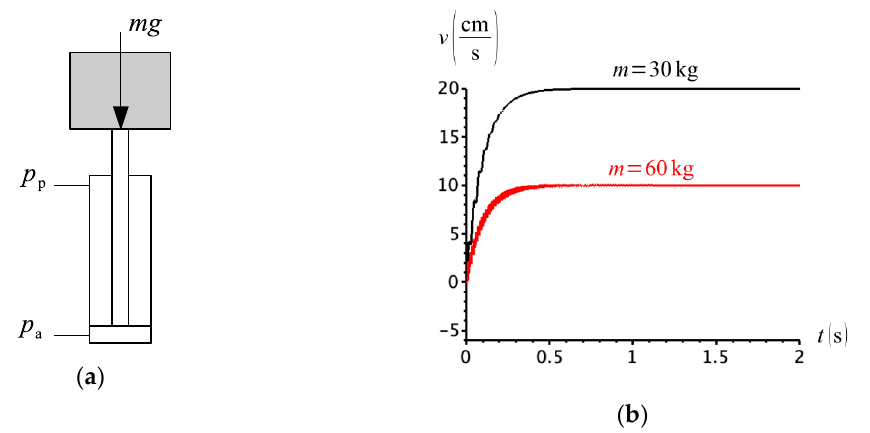
Figure 28. ( a ) Actuator lifting a weight; ( b ) extension velocity for different load masses.